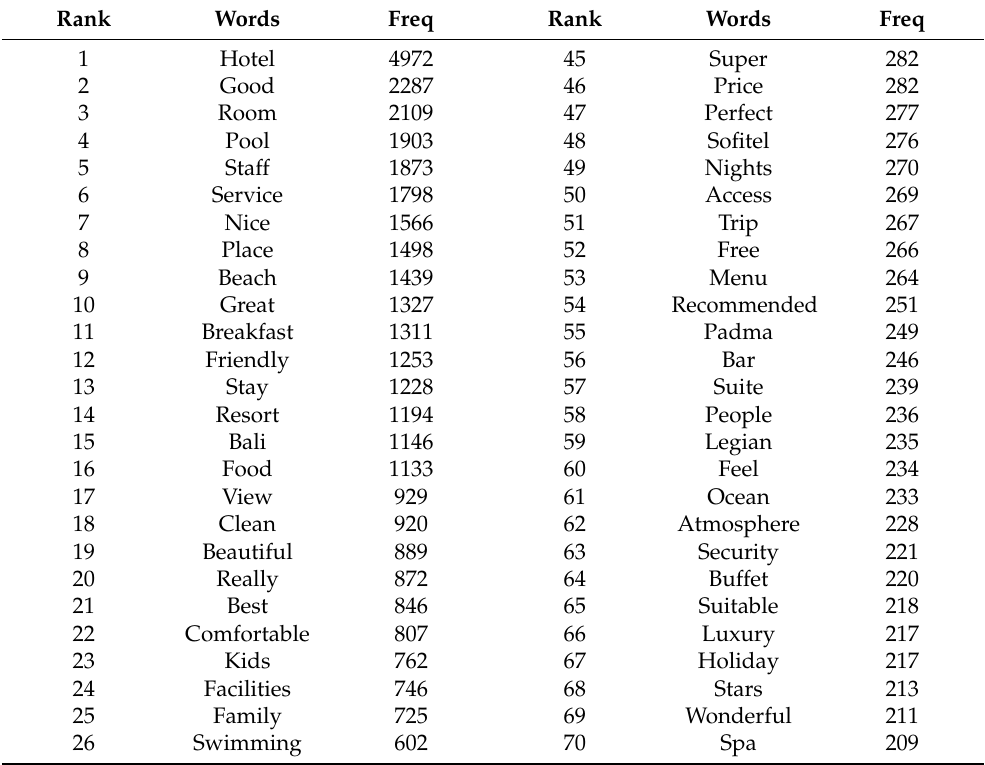
Table 3. Frequency of top keywords for luxury resorts in